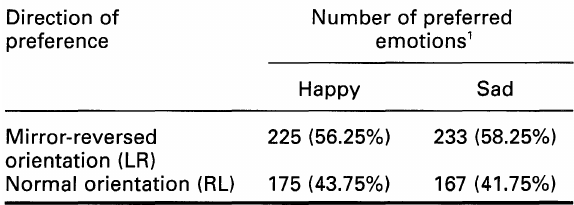
Number of preferred emotions' Happy Sad